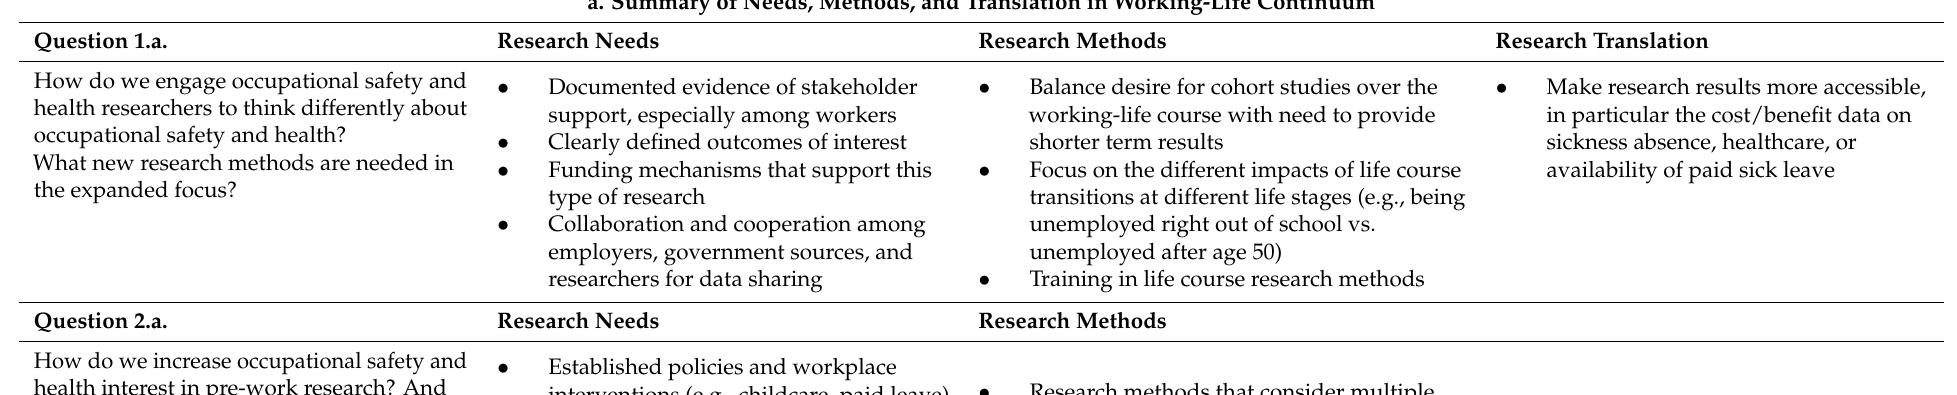
Table 2. (a) Summary of Needs, Methods, and Translation in Working-Life Continuum. (b) Summary of Needs, Methods, and Translation in Well-being Research. a. Summary of Needs, Methods, and Translation in Working-Life